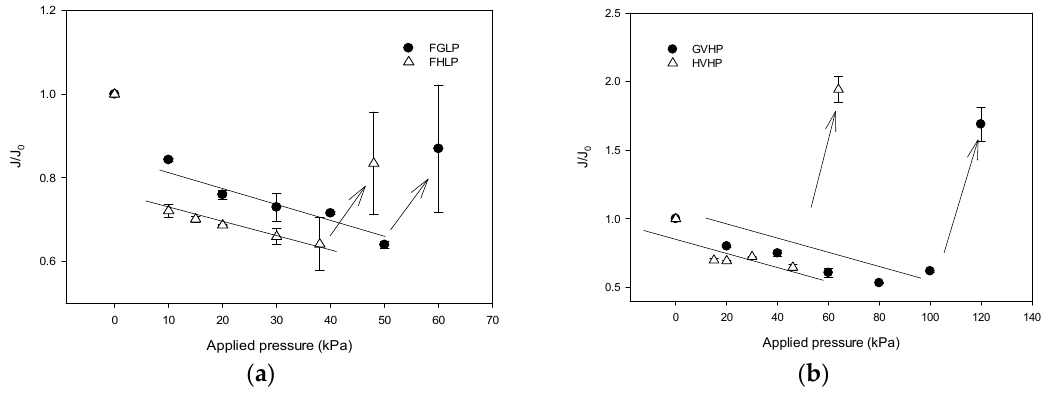
Figure 8. Dependence of J / J 0 on applied pressure ( Δ p ) in DCMD system. ( a ) PTFE membranes ( b ) PVDF membranes.